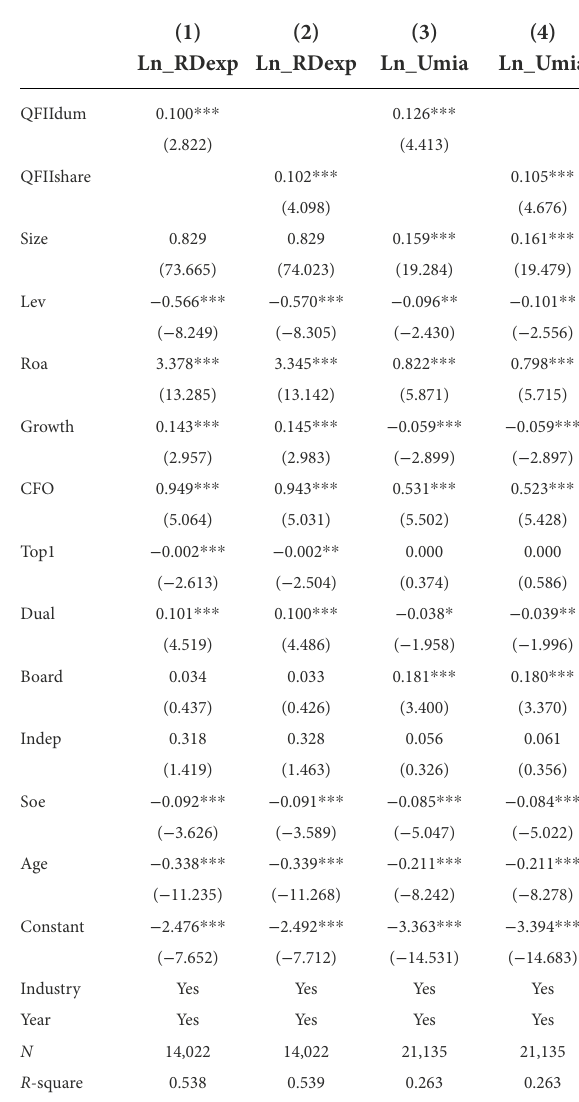
TABLE 9 Robustness test: the impact of QFII on corporate innovation under changing the measurement method of innovation